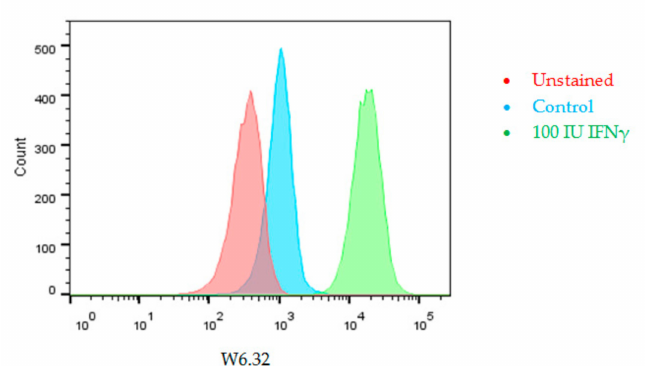
Figure 4. Interferon gamma (IFN γ ) treatment induces HLA Class I expression, determined with monoclonal antibody W6 / 32 and Fluorescence-Activated Cell Sorting (FACS) analysis on Uveal melanoma (UM) cell line 92.1, after 48 h